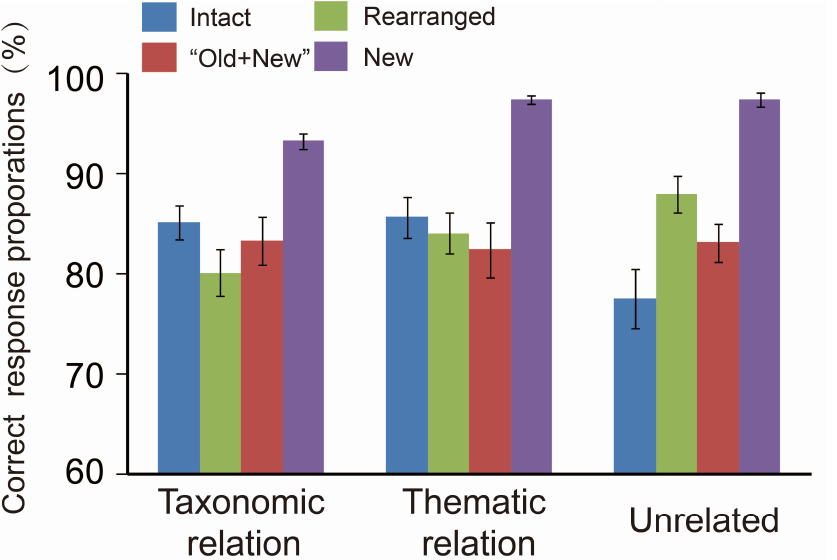
Figure 2. Correct response proportions as the function of pair type by semantic relation. Bars represent the standard errors.